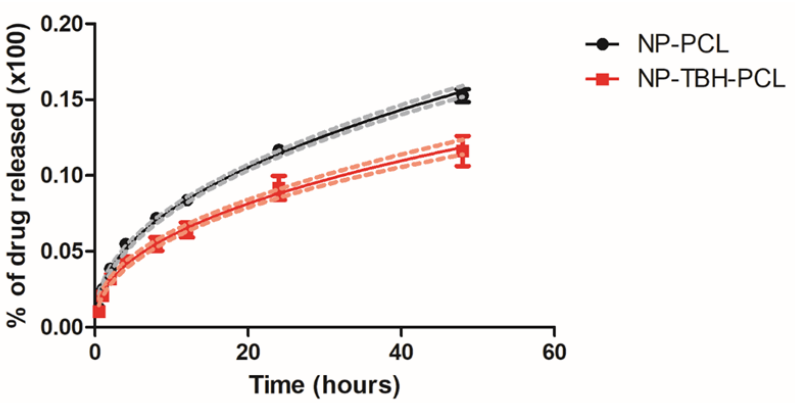
Figure 9. Cumulative release (%) of PCL-fluorescein-nanoparticle release with/out terbinafine from P407/casein hydrogel at 37 ◦ C in artificial sweat at a pH of 4.7. Data are average ± SD (n = 4). Some error bars are obscured by the symbols due to their small size. The continuous curves and their confidence interval are the best mathematical fit (dashed lines).